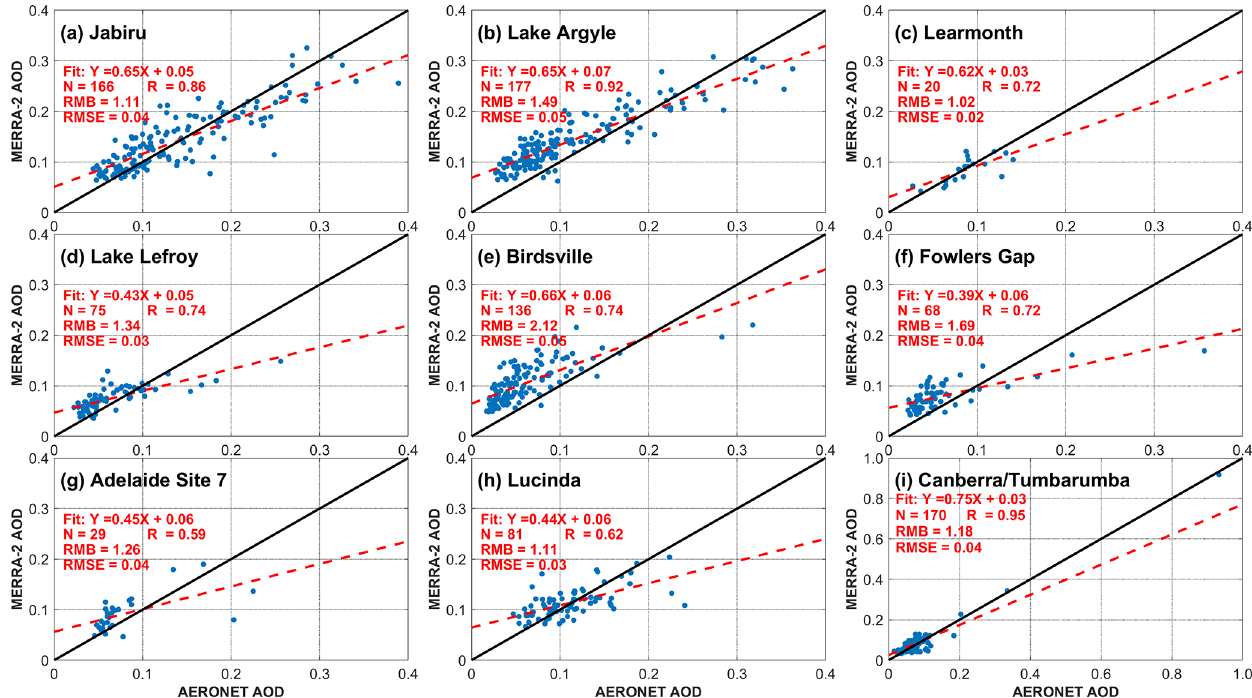
Figure 7. The comparisons of monthly AODs between the MERRA-2 product and AERONET at nine AERONET sites in Australia during 2002–2020. Linear regression is shown as a dashed red line, and all the linear relationships are statistically significant at α = 0.01. The solid black line is the 1 : 1 line.